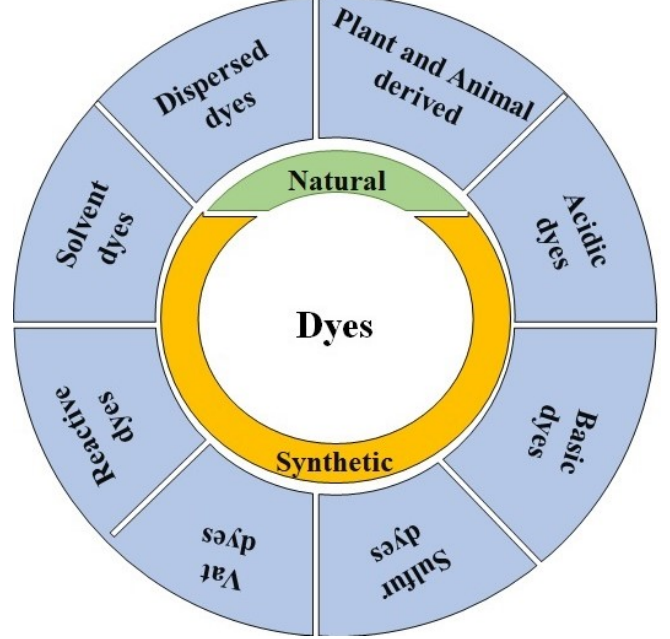
Figure 1. Classification of dyes.